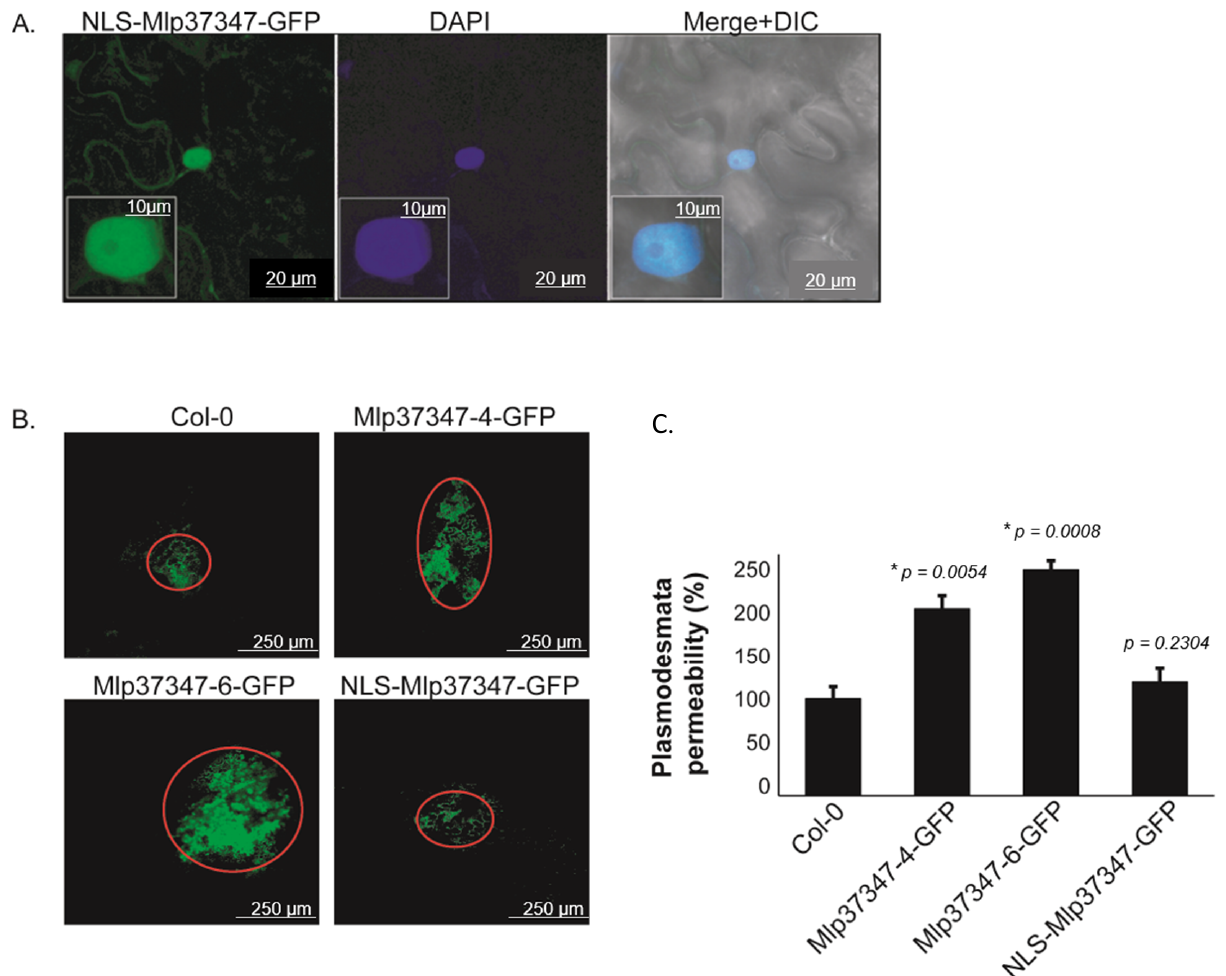
Figure 2. Plasmodesmata localization of Mlp37347 is required for enhanced plasmodesmatal flux. ( A ) Subcellular accumulation of NLS-Mlp37347-GFP in N. benthamiana epidermal cells at 3 days post-infiltration, the nucleus was stained by DAPI, and epidermal cells were observed under the green channel ( left panel ), blue channel ( middle panel ), and merge of the two channels +DIC ( right panel ). ( B ) DANS experiments were performed on the fifth and sixth leaves of three-week-old A. thaliana plants and imaged with the confocal microscope. ( C ) Permeabilities were measured in percentage compared to control. Data represent mean ± SD. The statistical difference from the control Col-0 leaves was determined by Student’s t -test, * p -values indicate statistical significance. Experiments were repeated at least three times ( N = 3), and representative data are shown.